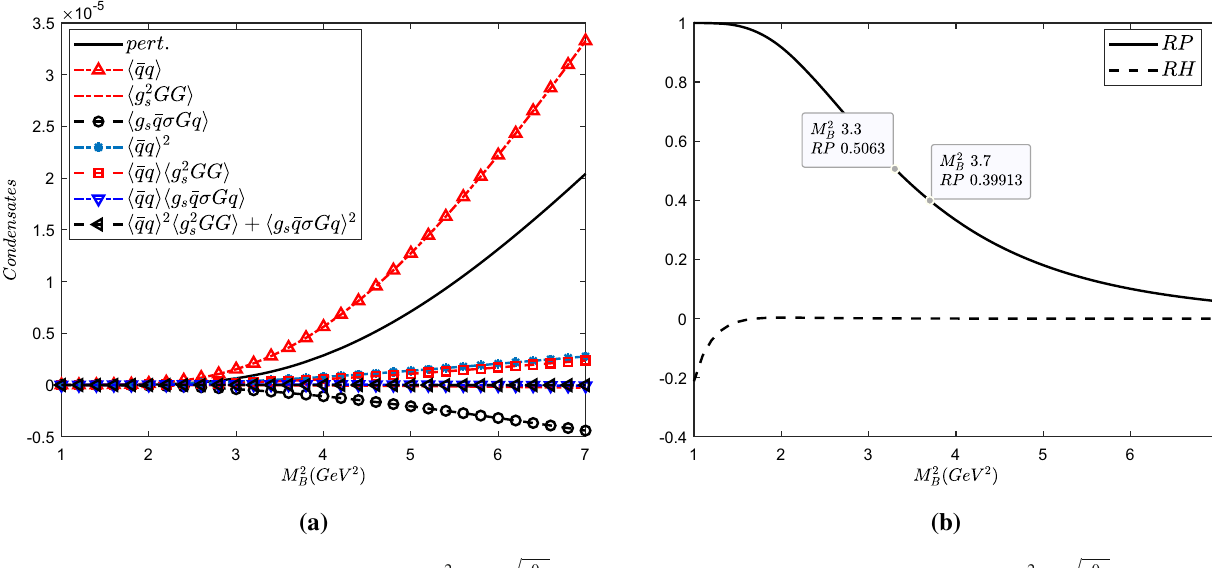
Fig. 1 a The various condensates as functions of M 2